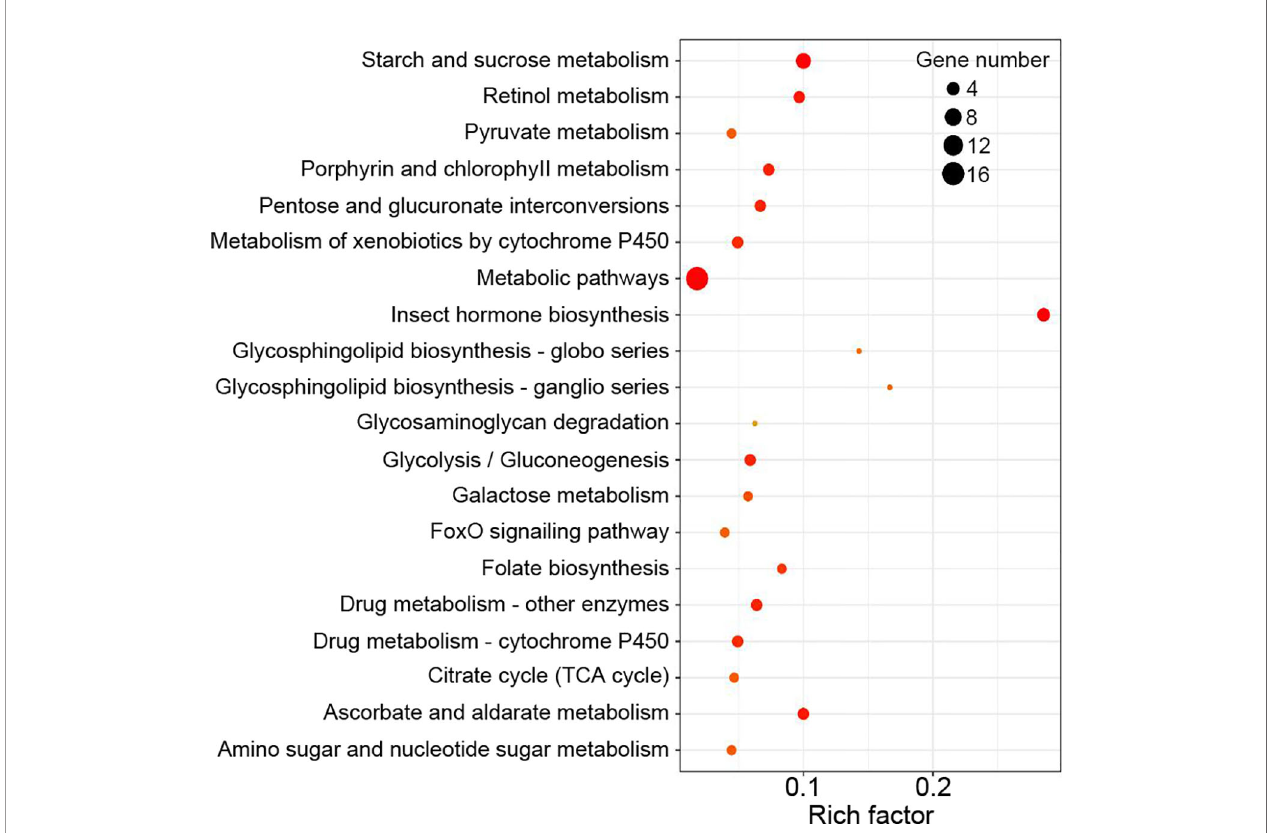
FIGURE 5 | Kyoto Encyclopedia of Genes and Genomes (KEGG) enrichment analysis. The KEGG pathways were considered signi fi cantly enriched by the differentially expressed genes (DEGs) expressions in different